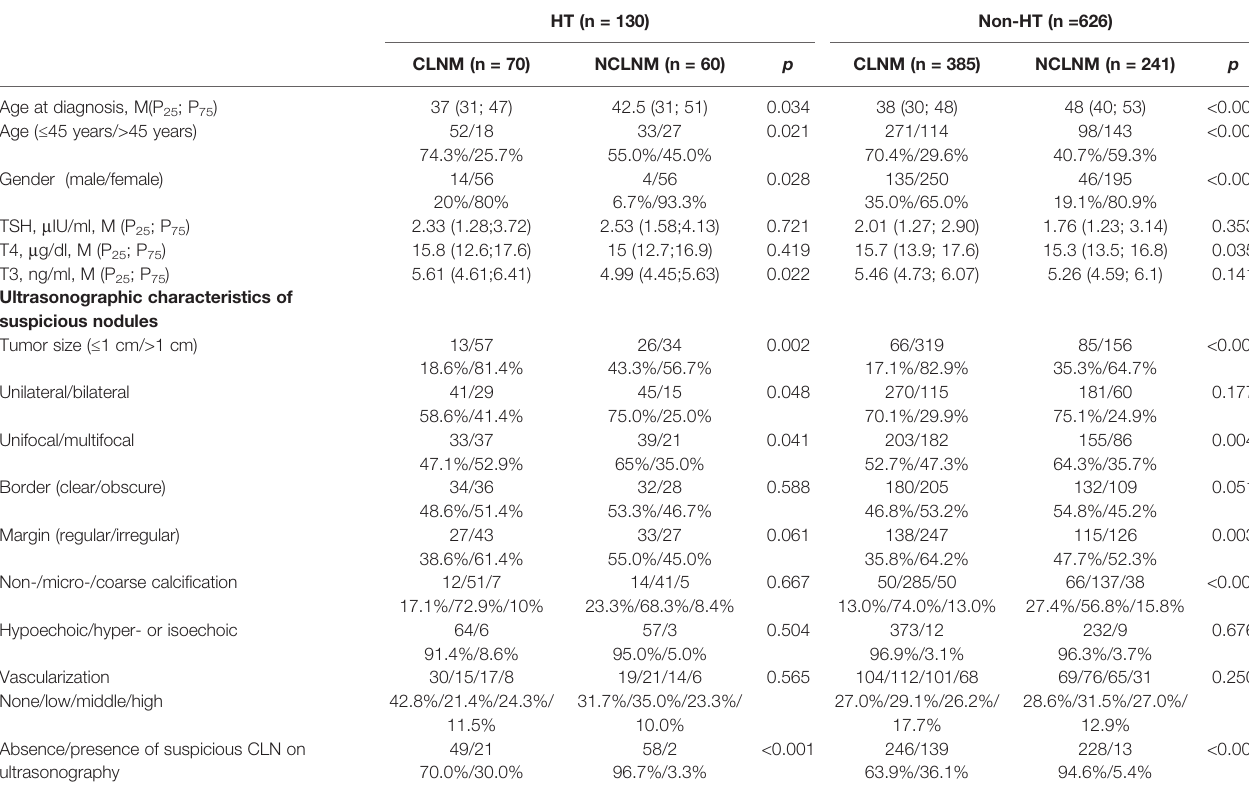
TABLE 5 | Univariate analysis of the correlation between clinical factors of the primary tumor and rate of CLNM in HT and non-HT PTC patients.